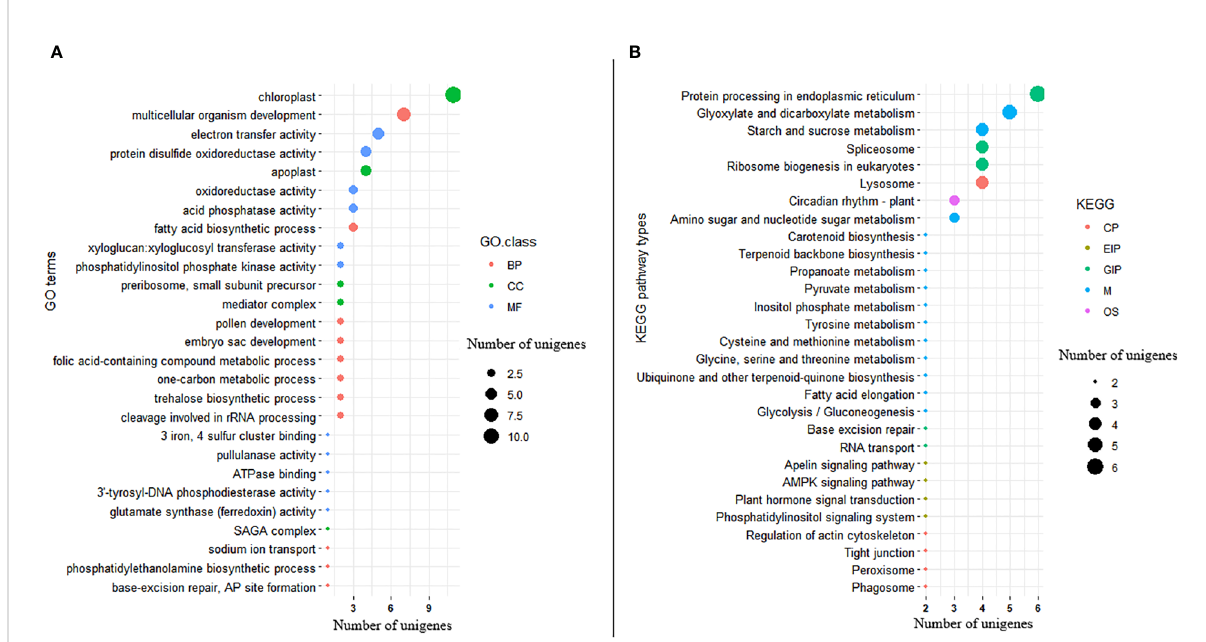
FIGURE 9 Bubble plot showing (A) distribution of GO functional annotation and (B) KEGG pathway classi fi cation of signi fi cantly differentially expressed genes. The Y-axis in GO annotation is the name of the GO terms, and the X-axis is the number of unigenes annotated to each GO term. Similarly, the Y-axis in KEGG pathway classi fi cation is the name of the KEGG metabolic pathway, and the X-axis is the number of unigenes annotated to each